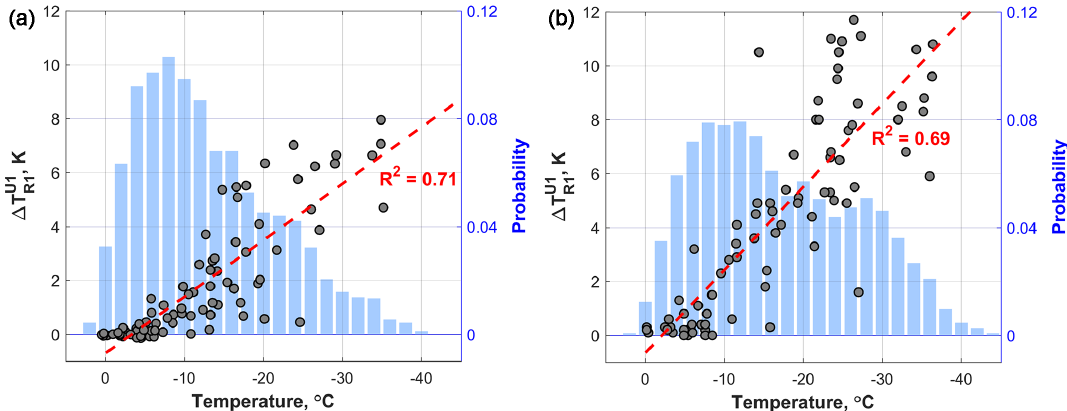
Figure 4. The observed daily mean (a) and daily maximum (b) temperature difference (cid:49)T U1 and (b) the daily minimum temperature at the R1 station during the winter of 2015–2016. The red line shows the linear regression. The blue vertical bars show the probability distribution of the (a) daily mean and (b) daily minimum temperature at the R1 station for the winter months (DJF) of 1986–2016. Probability is calculated for temperature bins with a 2K